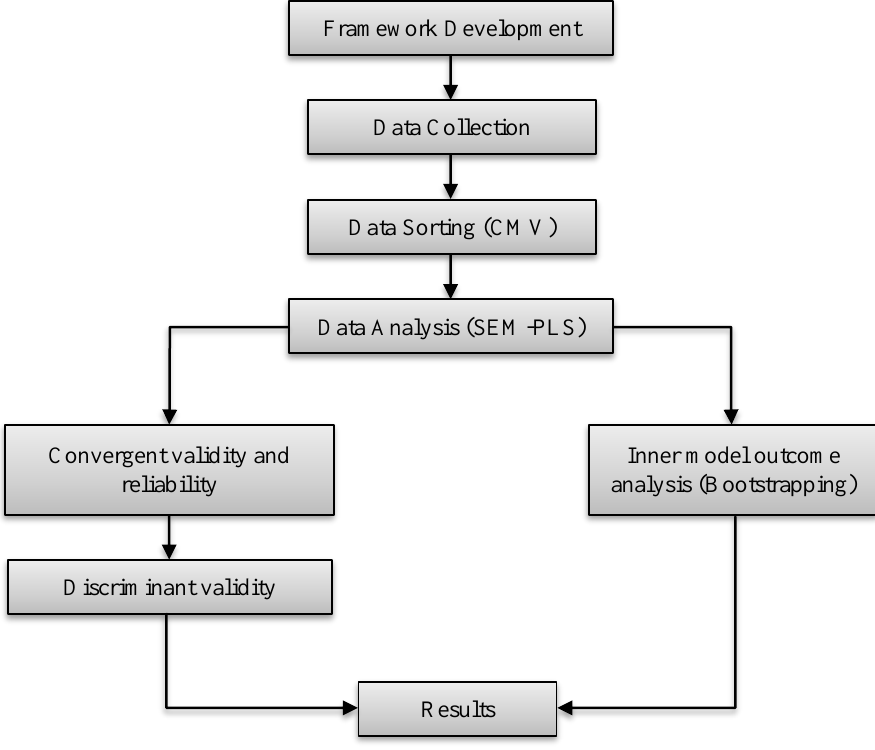
Figure 2. Flowchart of research methodology